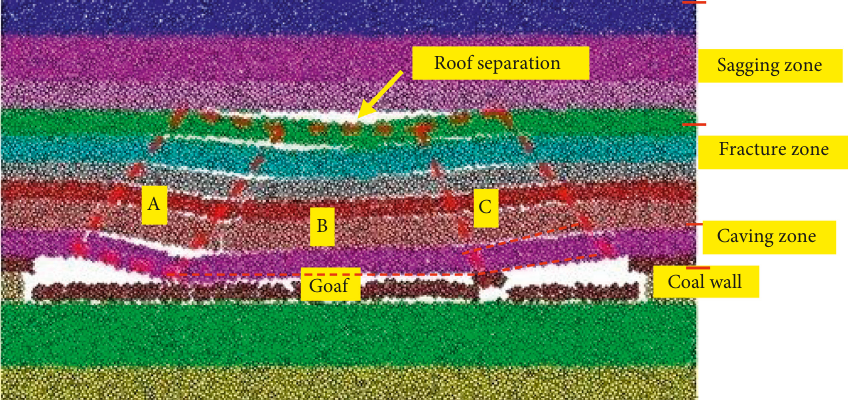
Figure 13: The fracture distribution of roof rock